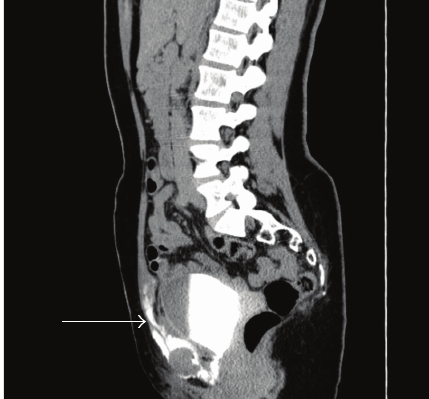
Figure 3: Lateral view showing extravasation of contrast solution into the soft tissues of the lower abdomen (white